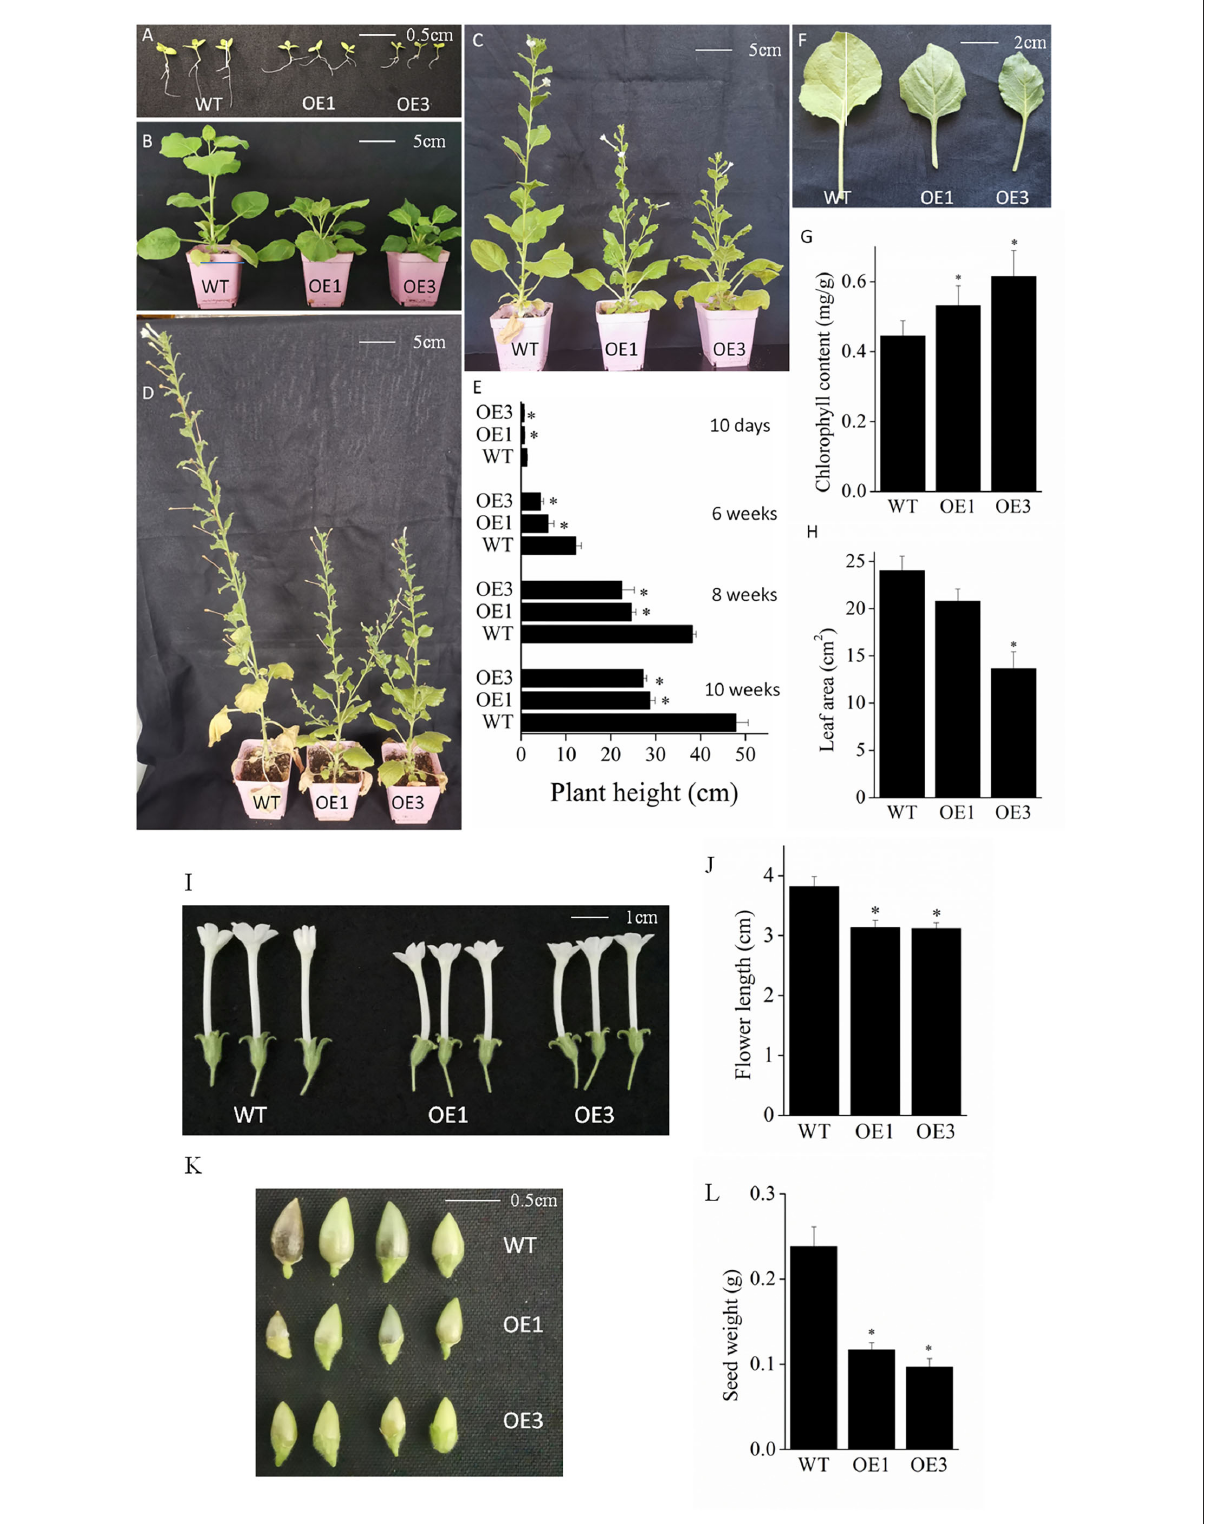
FIGURE3 Phenotypic analysis of VyMYB24 transgenic tobacco plants. The phenotypes of 10-day seedlings (A) , six-week plants (B) , eight-week plants (C), and ten-week plants (D) were observed, and the plant height was measured (E) . Leaves from six-week plants (F) were chosen to measure the leaf area (G) and the chlorophyll content (H) . The flowers (I) and seeds (K) were photographed and the flower length (J) and seed weight (L) were evaluated. Bars represent mean ± SD. A significant difference from the WT was confirmed by a one-way ANOVA test, * p <